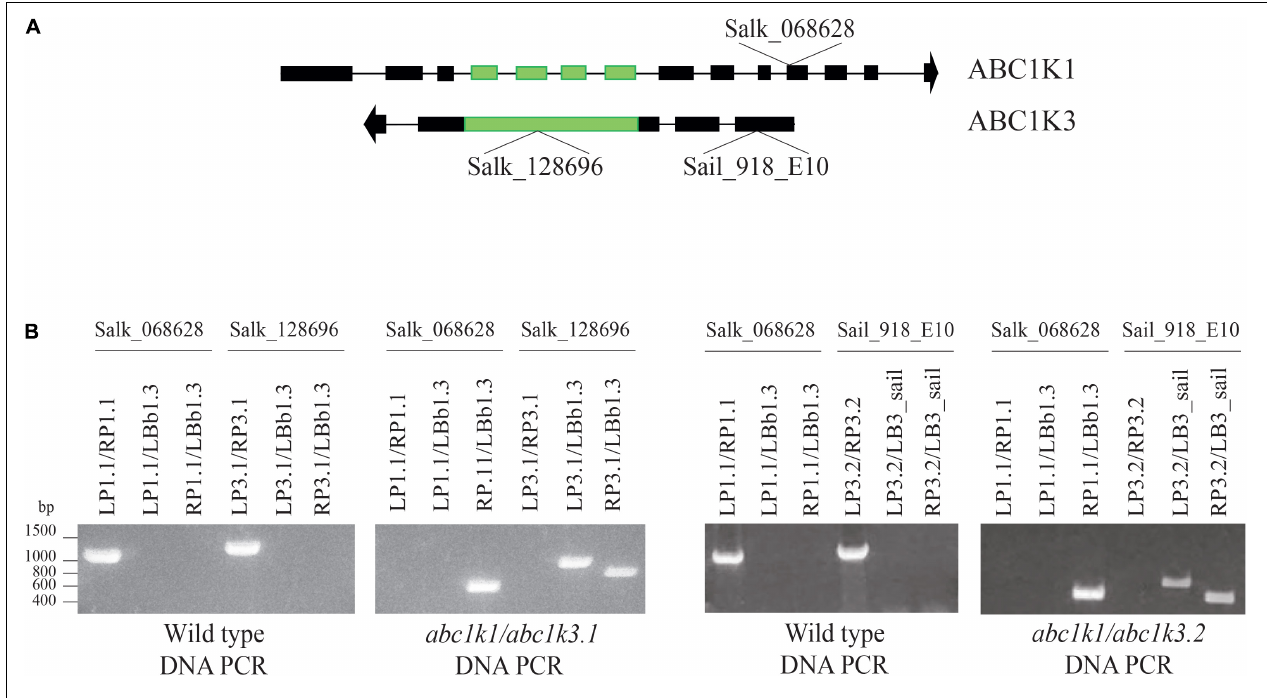
FIGURE 1 | Selection and isolation of abc1k1/abc1k3 double mutant lines. (A) Schematic representation of the position of the T-DNA insertions in ABC1K1 (At4g31390) and ABC1K3 (At1g79600) gene sequences. (B) Electrophoresis of the amplification products obtained from genomic DNA extracted from Wild type, abc1k1/abc1k3.1 and abc1k1/abc1k3.2 confirm the homozygous mutation of both loci. The double mutant abc1k1/abc1k3.1 was obtained from the crossing between abc1k1.1 (SALK_068628) and abc1k3.1 (SALK_128696), while abc1k1/abc1k3.2 is the result of the crossing between abc1k1.1 (SALK_068628)